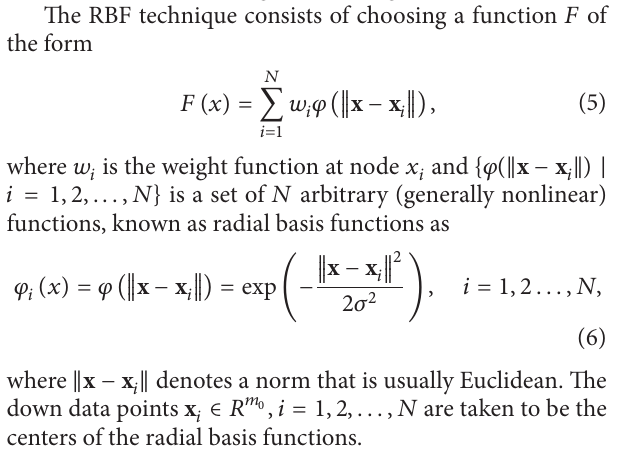
specimen during welding which causes uneven heat genera- tion. In addition, during IFW process, peak temperature at the interface is below the melting point of GH4169 (1260– 1340 ∘